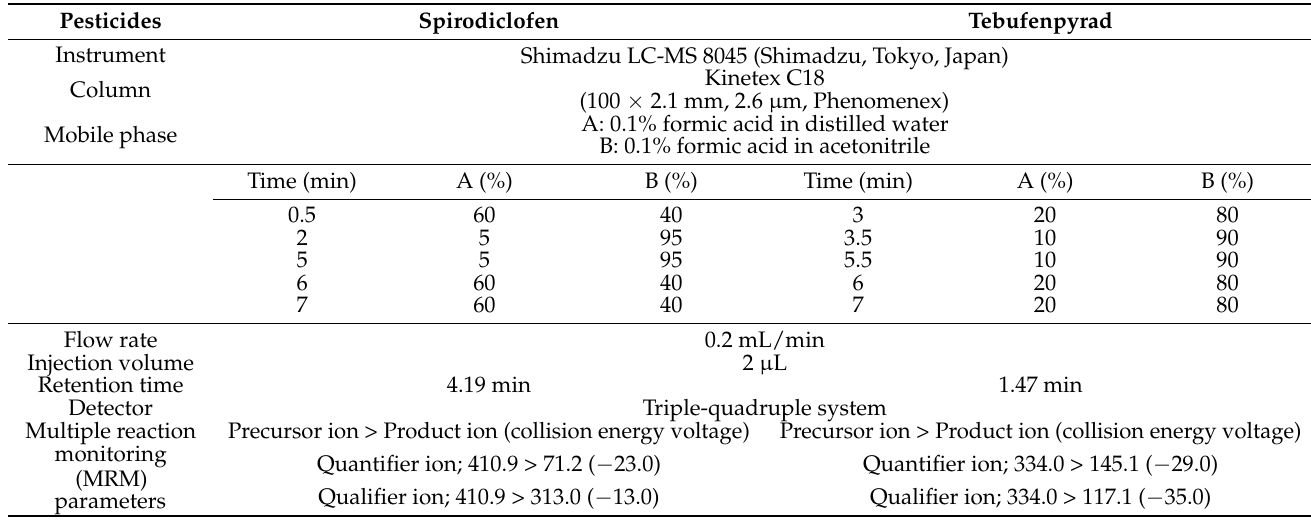
Table A2. Analytical conditions of spirodiclofen and tebufenpyrad in Aster scaber